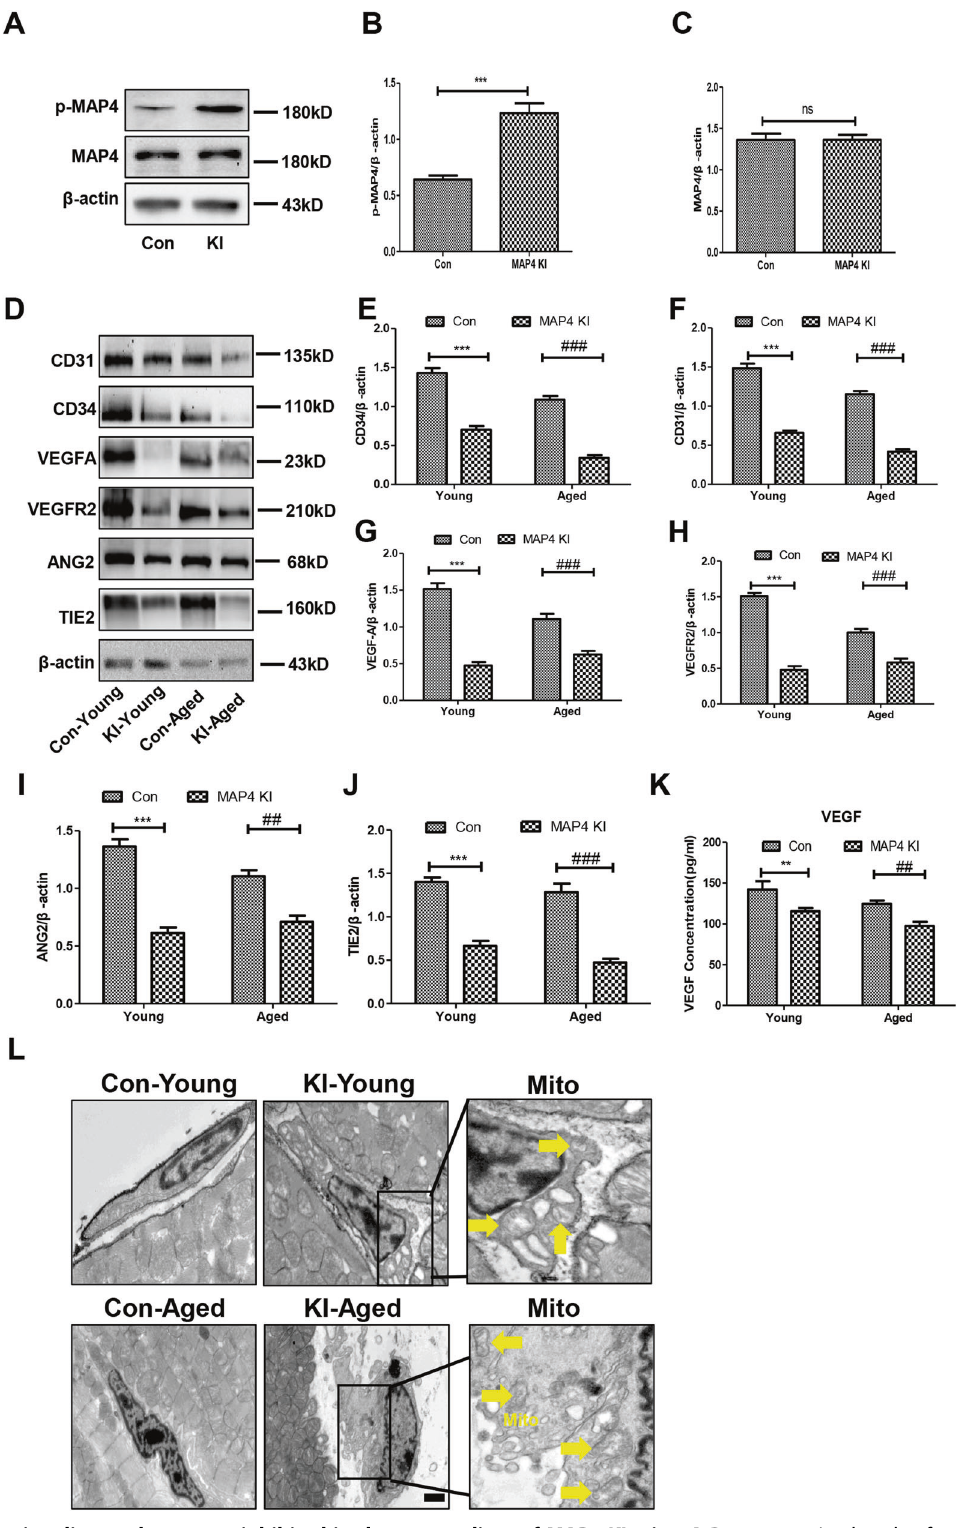
Fig. 1 Angiogenic signaling pathways are inhibited in the myocardium of MAP4 KI mice. A Representative bands of western blotting for detecting p-MAP4 in the myocardium; n = 5. B , C The statistical analysis of p-MAP4, and MAP4. *** p < 0.001 versus the Con group. N.S. represents no statistical difference between the Con and MAP4 KI groups; n = 5. D Representative immunoblotting bands of the levels of CD31, CD34, VEGFA, VEGFR2, ANG2, and TIE2 in the myocardium; n = 5. E – J The statistical analysis of CD31, CD34, VEGFA, VEGFR2, ANG2, and TIE2. *** p < 0.001 versus the Con-young group; ## p < 0.01 and ### p < 0.001 versus the Con-aged group; n = 5. K A scatter diagram showing the concentration of VEGF in the plasma. N.S. represents no statistical difference between the Con-young and MAP4 KI-young groups. ## p < 0.01 versus the Con-aged group; n = 8. L Representative TEM images of endothelial cells in the myocardium. Yellow arrows point to disrupted mitochondria. Scale bar, 0.5 µm; n = 3. Cell Death Discovery (2021)